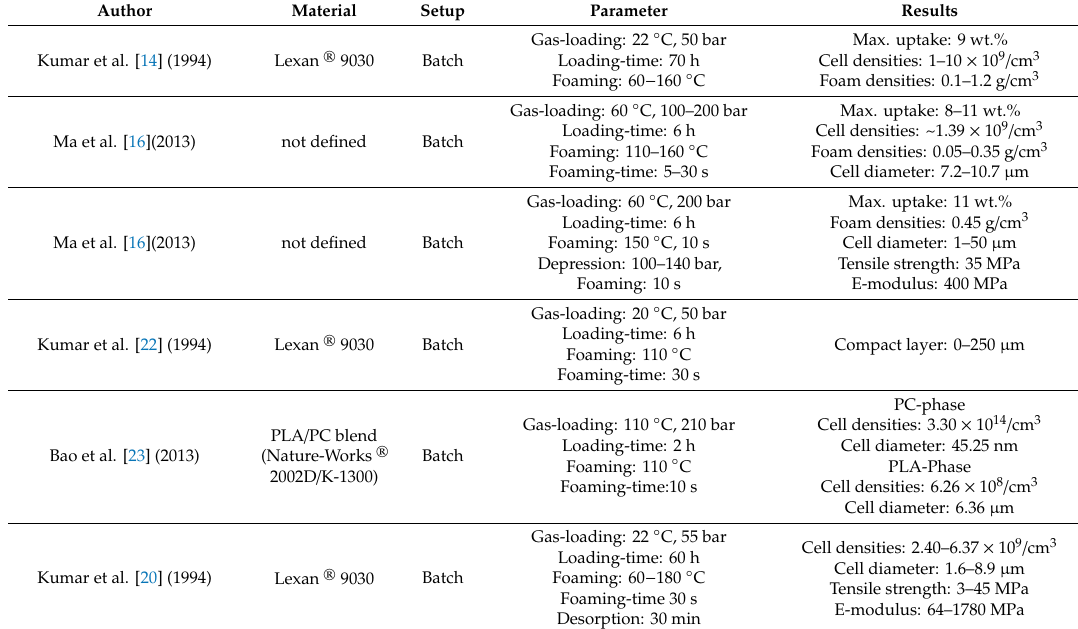
Table 1. Literature review for polycarbonate